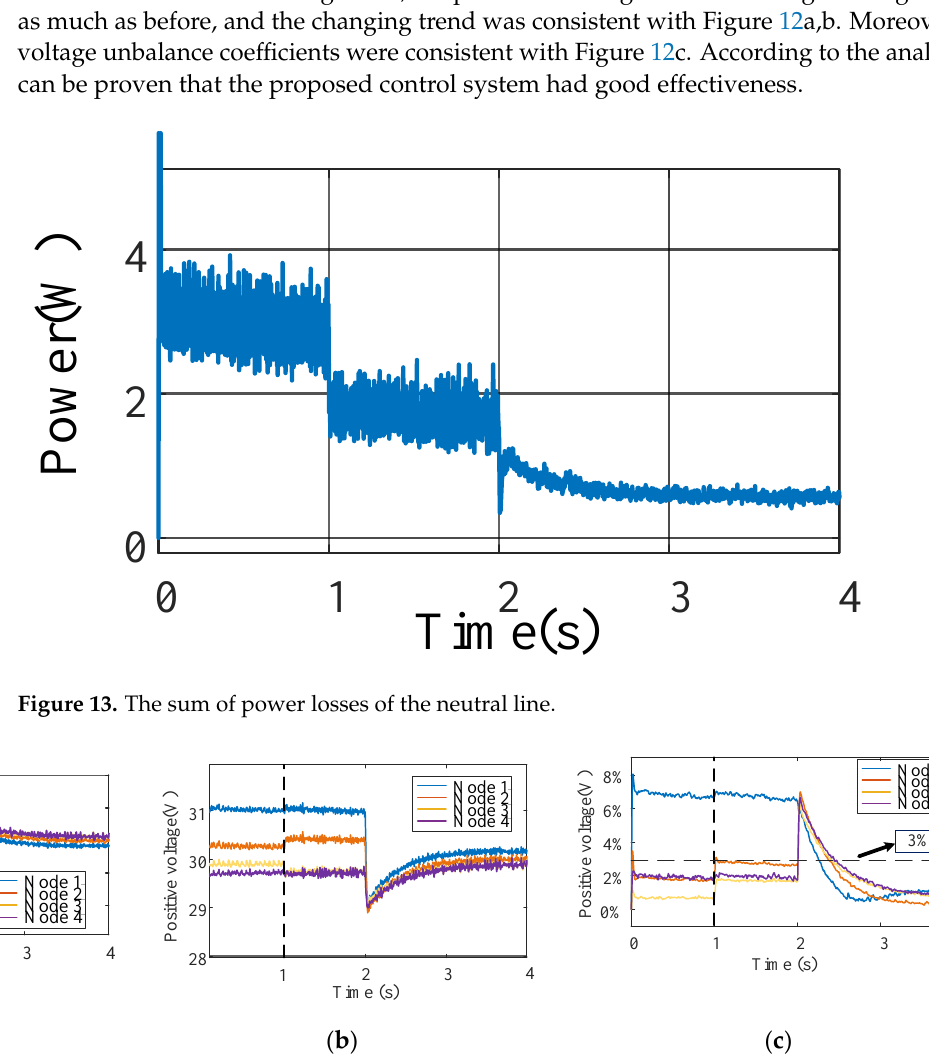
Figure 14. When the bus voltage is increased to 60 V, the effects on the ( a ) positive load voltage, ( b ) negative load voltage and ( c ) voltage unbalance coefficient under the proposed consensus control.